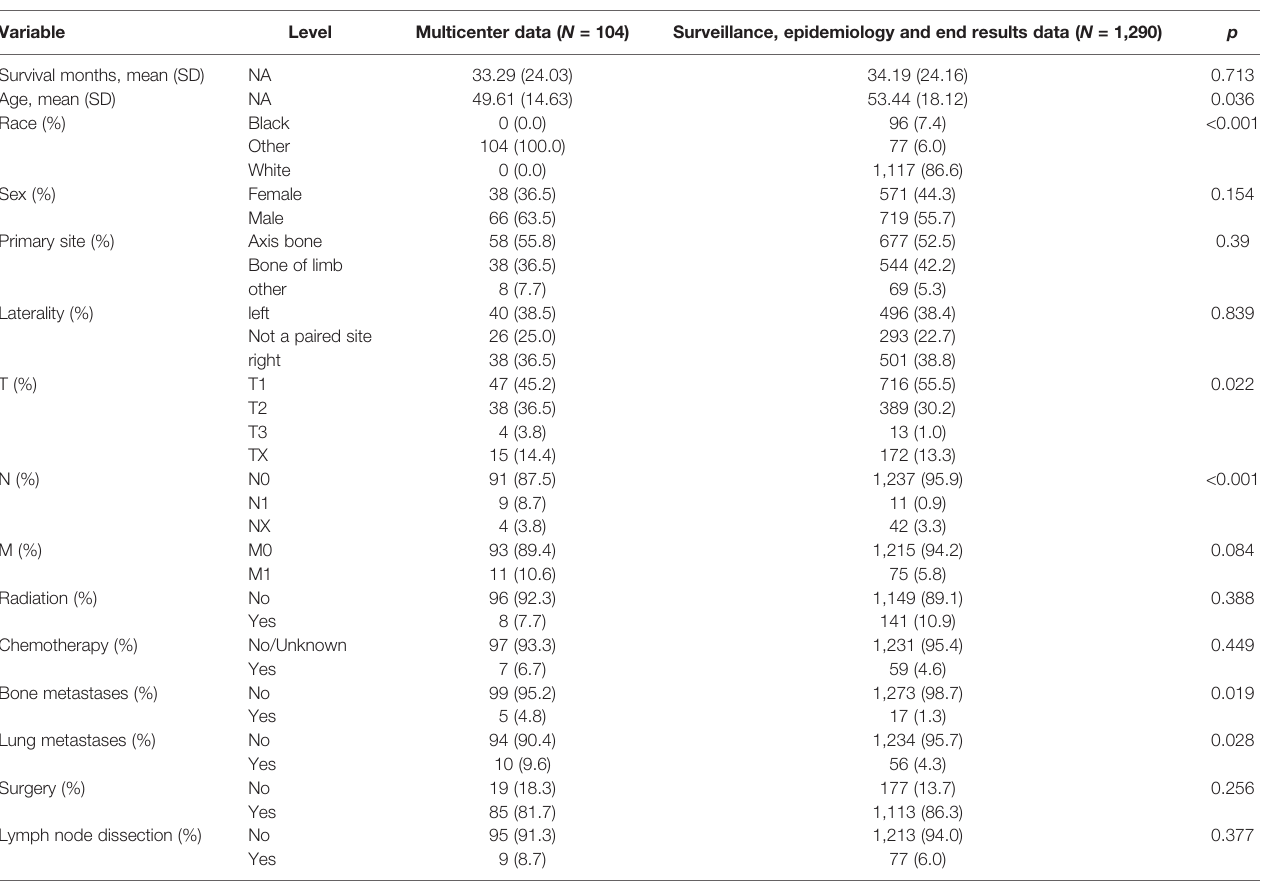
TABLE 1 | Baseline data table of the training group and the validation